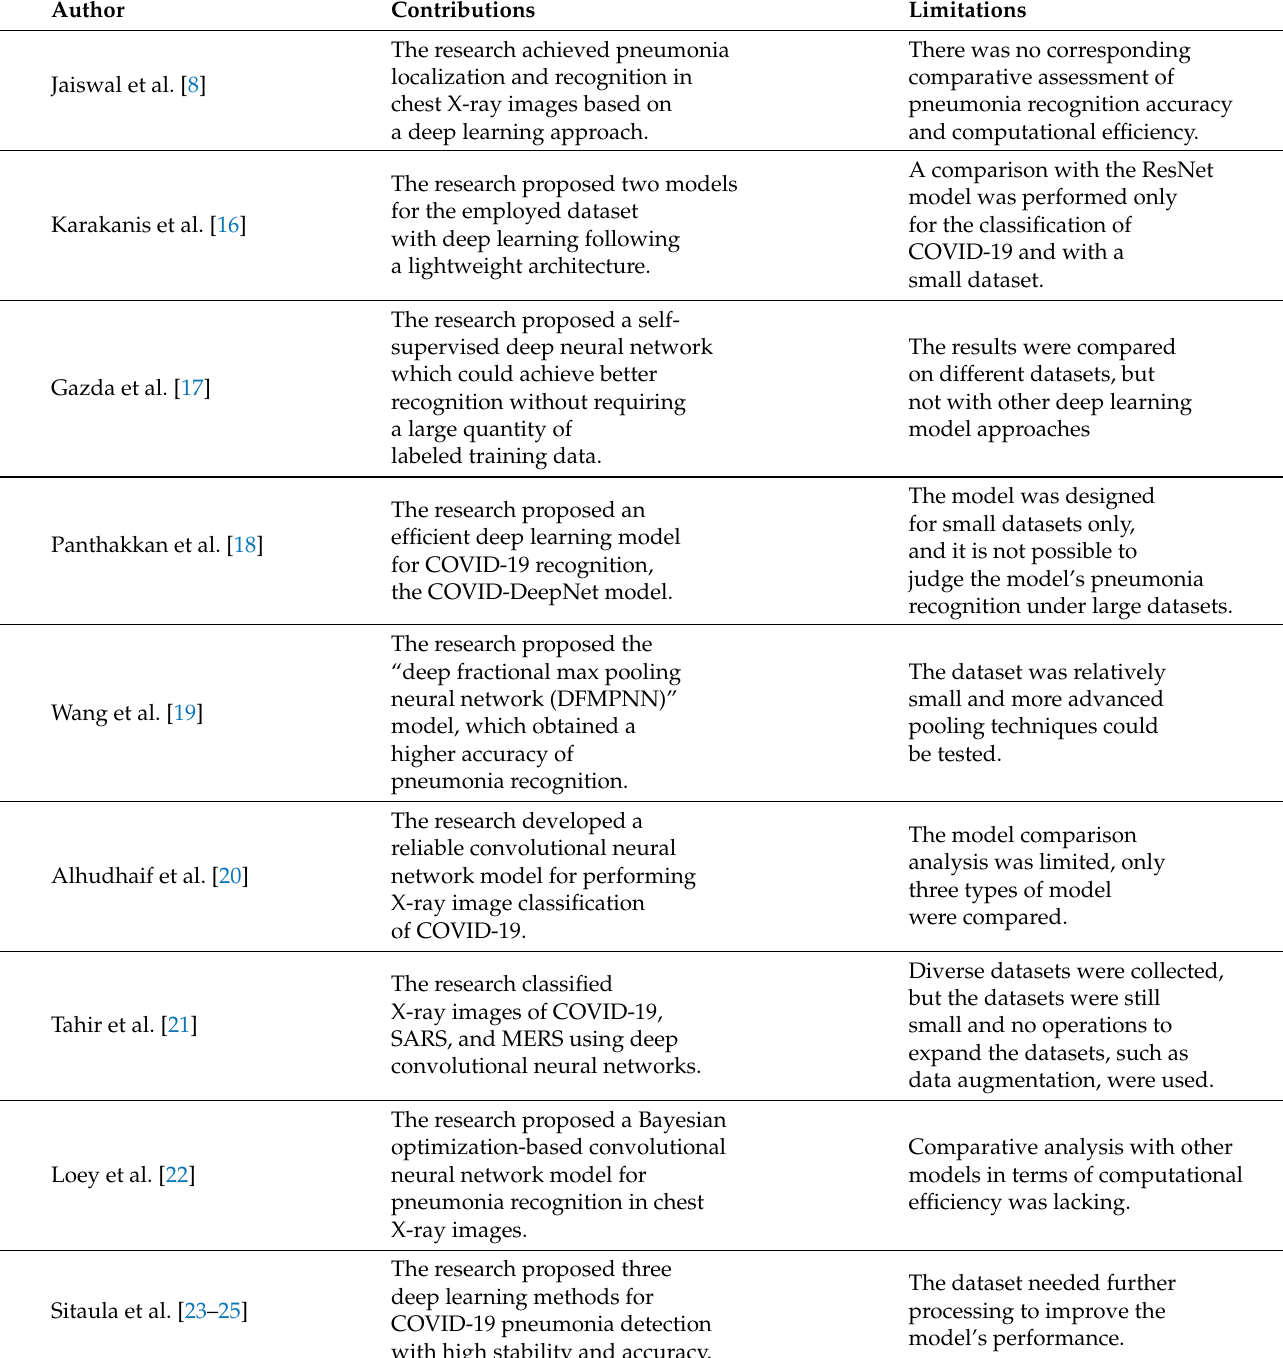
Table 1. Comparison of related